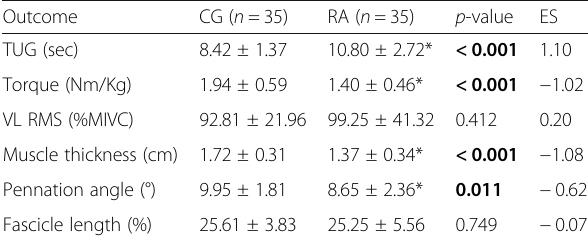
Table 2 Functional capacity, muscular strength